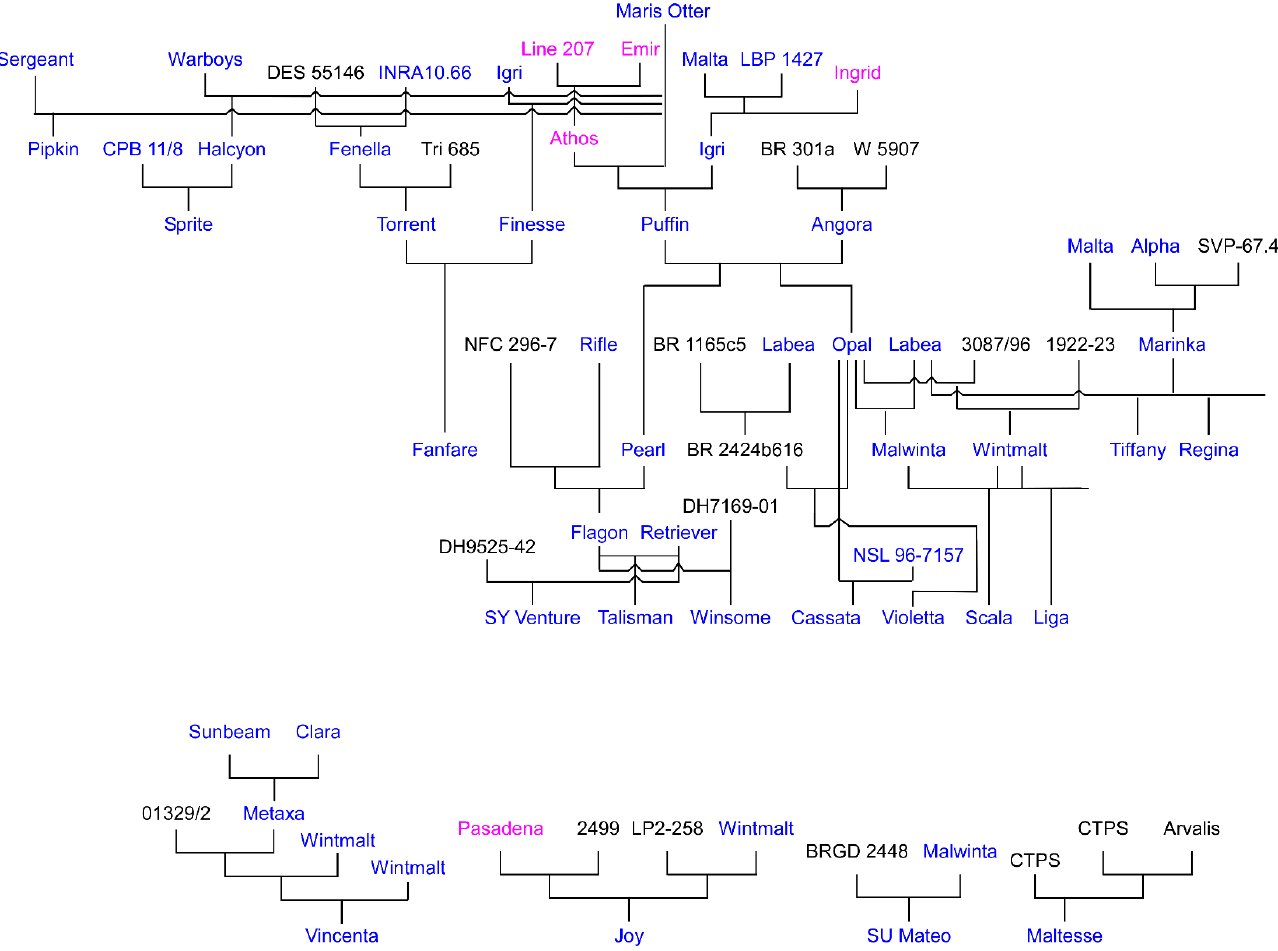
Figure 1. Pedigree tree of winter malting barley varieties grown in the UK and Europe, and those marketed in the U.S. Blue text are winter lines, pink text are spring lines, and black text are lines of uncertain growth habit that are breeder-specific.